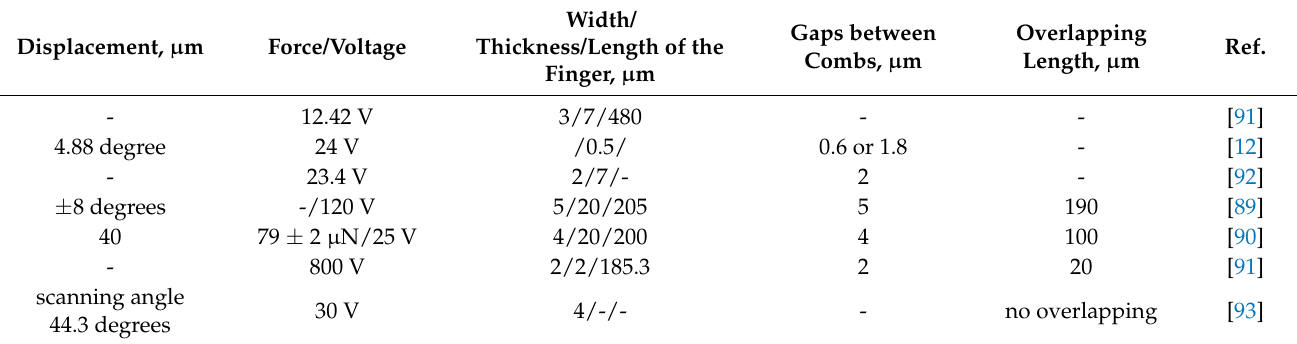
Table 5. Design of comb-drive actuators reported in last 5 years.